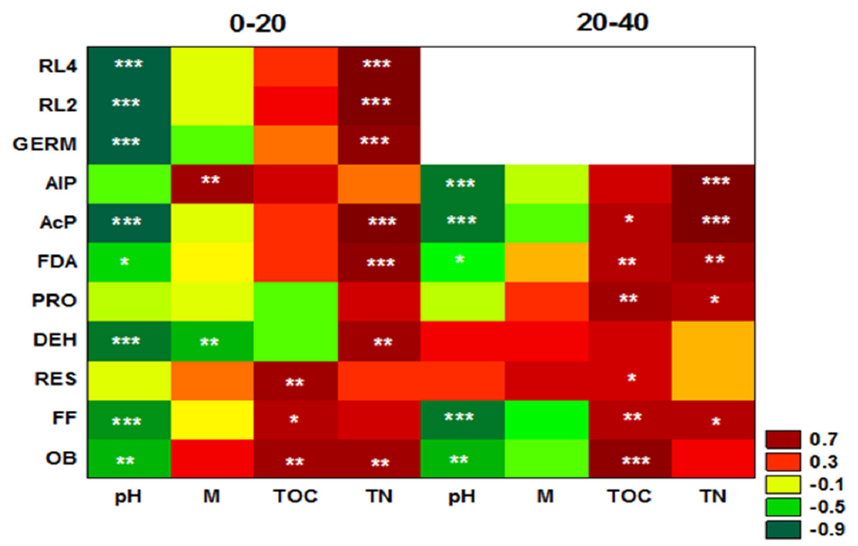
Figure 8. Heat map displaying the Pearson correlation coefficients between chemical and physi-